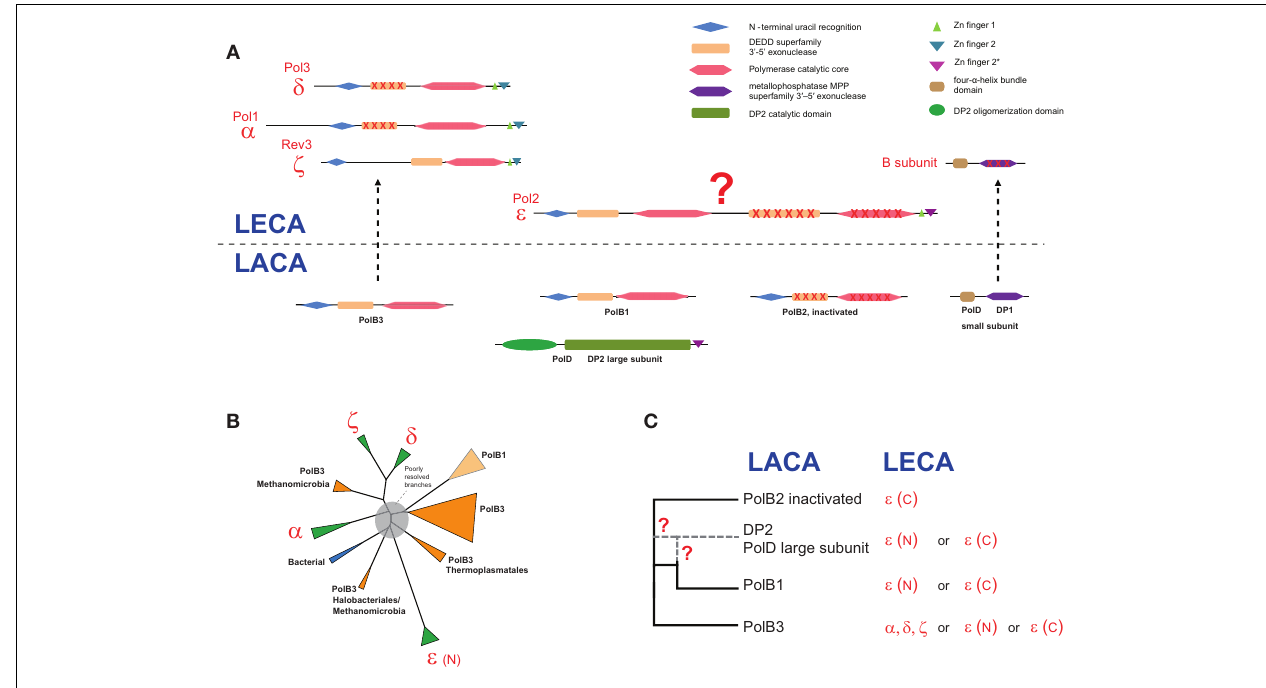
FIGURE 4 | Reconstruction of the complements of replicative DNAPs in the last archaeal and eukaryotic ancestors and a hypothetical scenario of their evolutionary relationships. (A) Polymerase B and D family genes projected to archaeal (LACA) and eukaryotic (LECA) last common ancestors and their domain organization. Homologous domains are shown by shapes of the same color. Inactivated domains are crossed. For eukaryotic polymerase families, human and yeast gene names are provided. (B) The unrooted phylogenetic tree of active polymerases of B family. The MUSCLE program